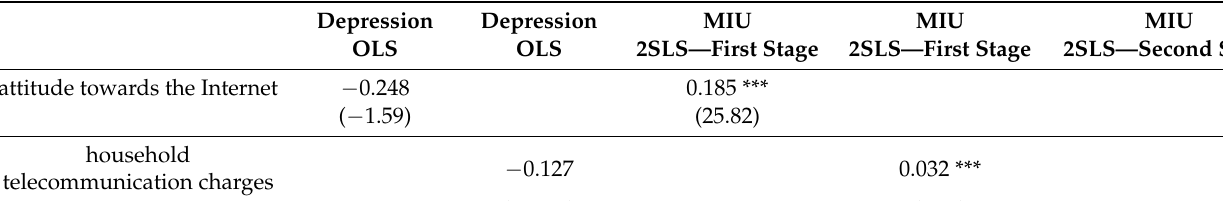
Table 4. Instrument variable